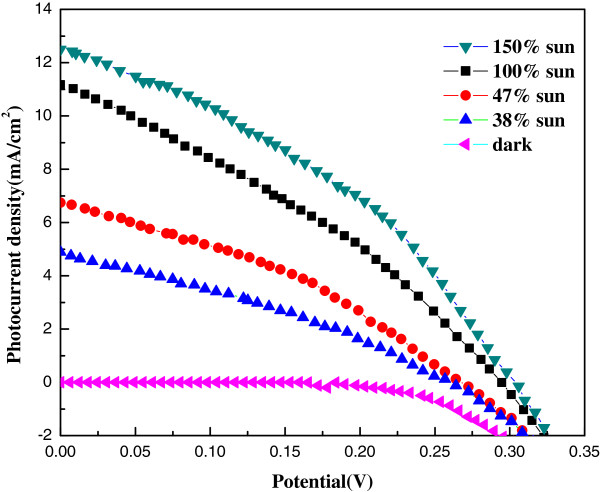
J-V curves of Ag2S QD-sensitized solar cell measured at different light intensities.